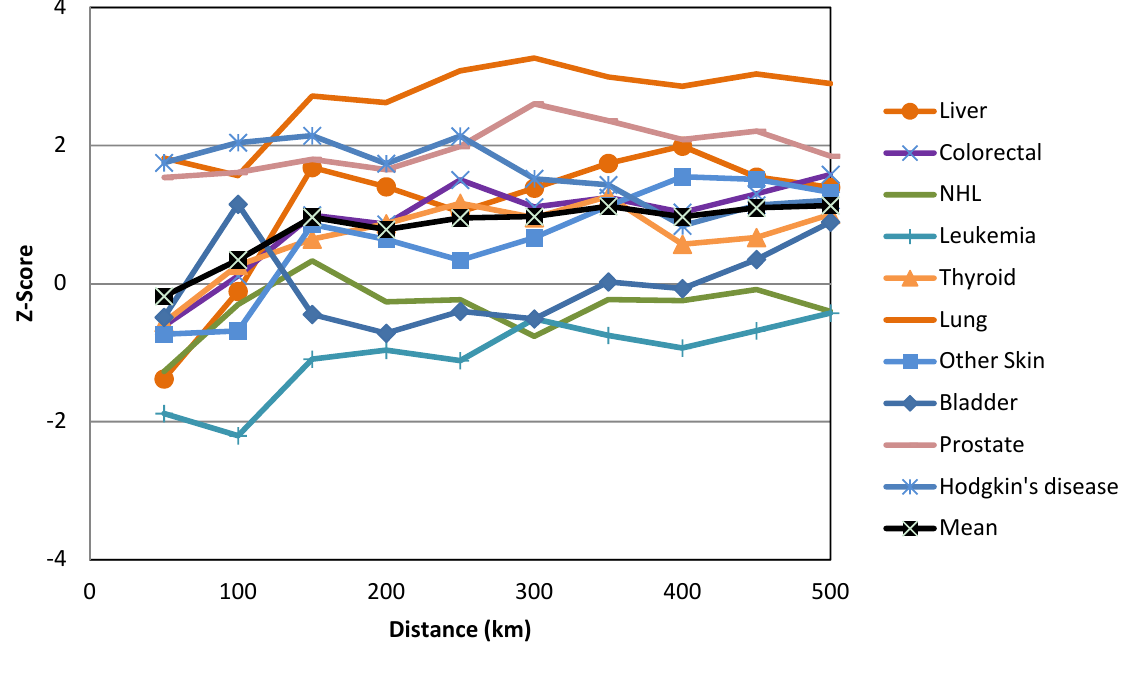
Figure 2. Z-scores of the global Moran’s I statistics for the most common cancers in males.